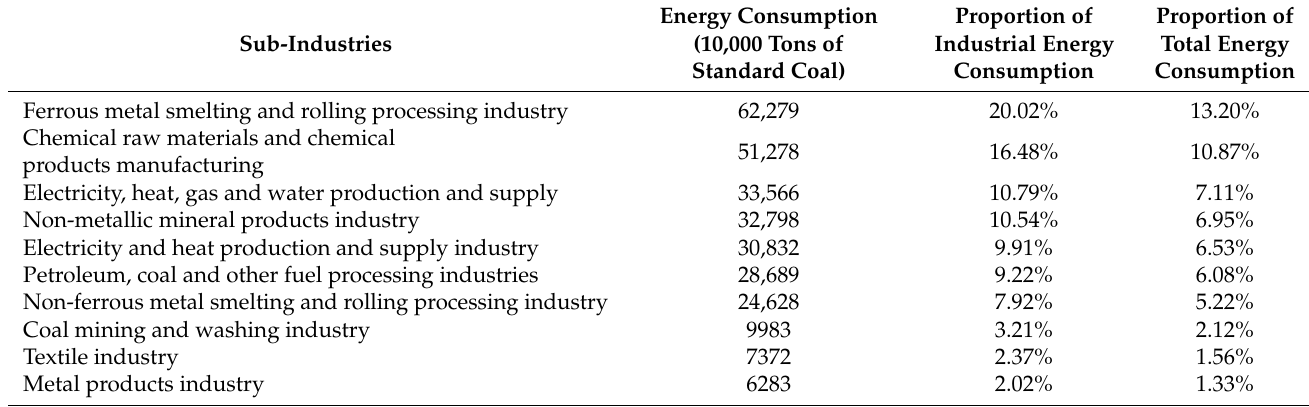
Table 1. Top 10 industries in China’s industrial energy consumption in